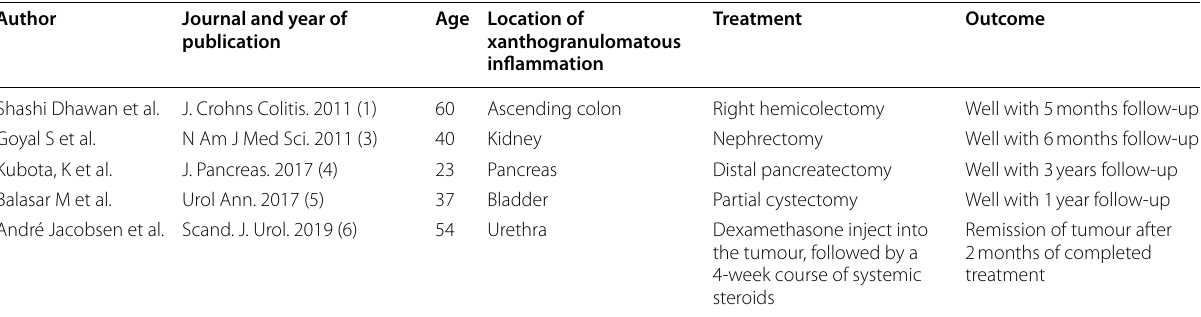
Table 1 Comparison of different location of xanthogranulomatous inflammation and intervention outcome (1, 3, 4, 5,